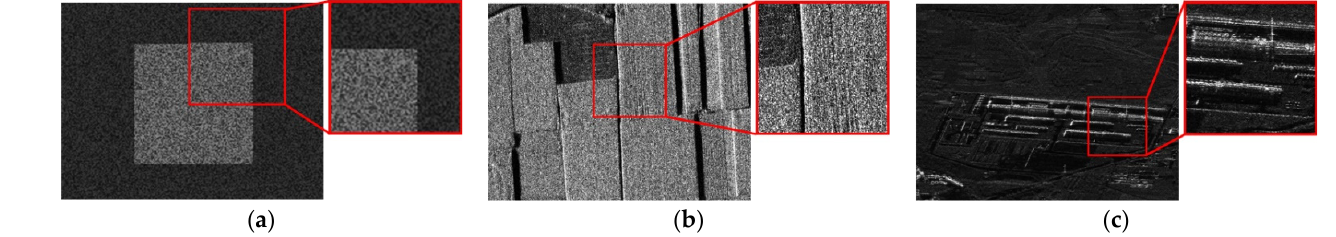
Figure 1. Three examples for presentation of the speckle noise; ( a ) is a synthetic speckled image; and ( b ) and ( c ) are two Ku-band airborne SAR images containing various targets.